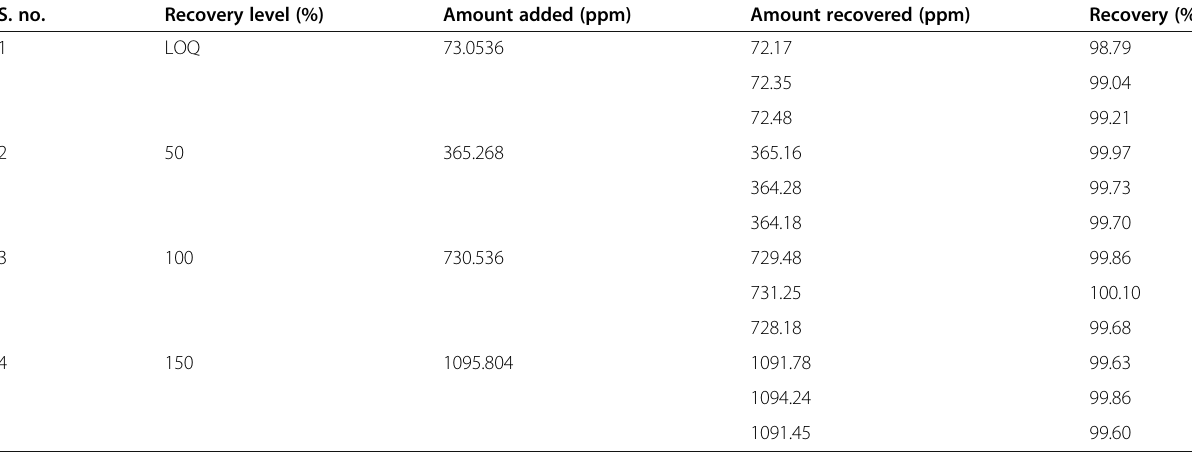
Table 15 Results of recovery study for tetrahydrofuran S. no.